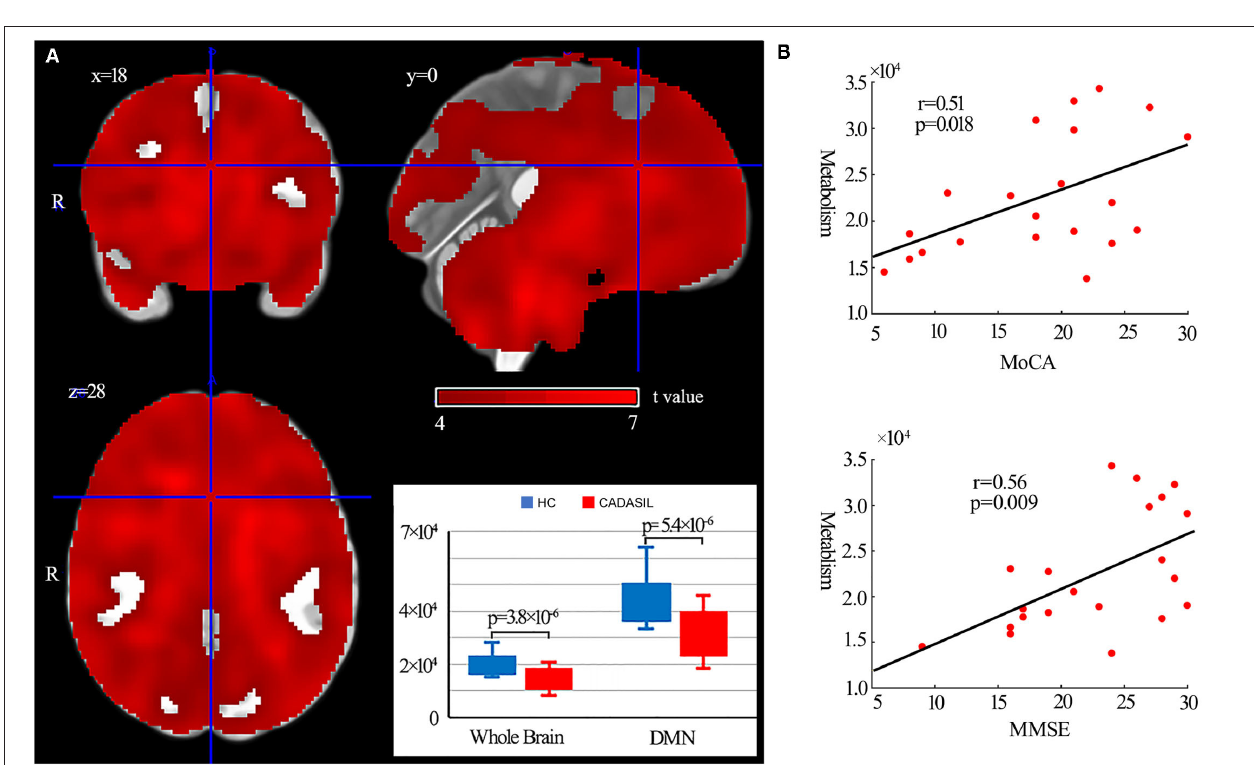
FIGURE 5 | Results of metabolism analysis in the DMN in CADASIL and control groups. (A) Metabolism alterations in the CADASIL group. (B) Correlations between metabolism across ROIs within the DMN and cognitive scores in the CADASIL group. Patients with CADASIL had decreased metabolism across the whole brain, including the ROIs within the DMN, compared with healthy controls. DMN, default mode network; CADASIL, cerebral autosomal dominant arteriopathy with subcortical infarcts and leukoencephalopathy; ROI, region of interest; HC, healthy control; MoCA, Montreal Cognitive Assessment; MMSE, Mini-Mental State Examination.